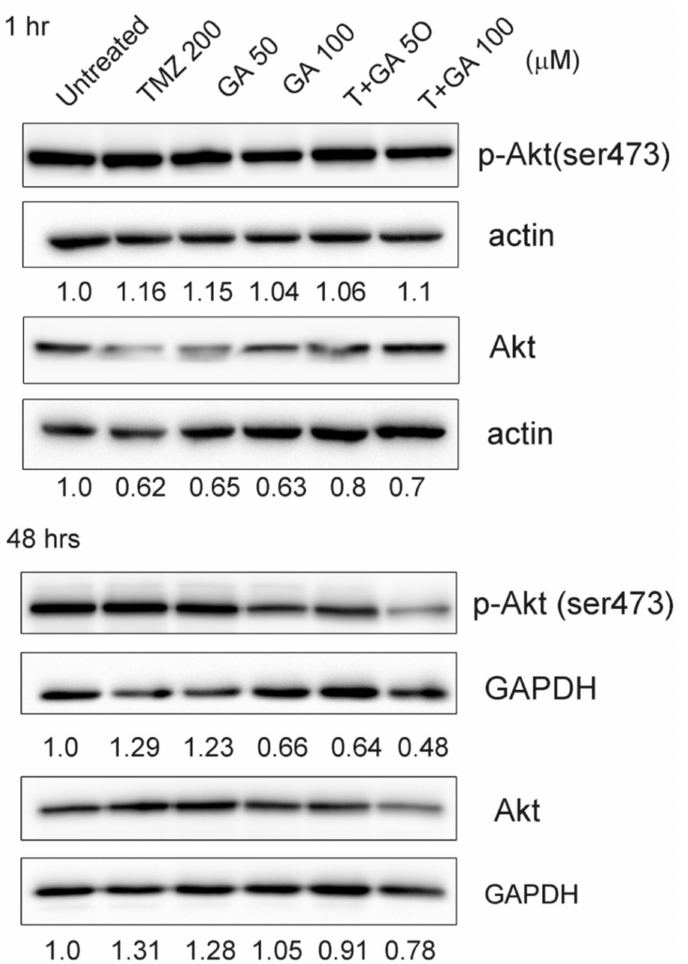
Figure 6. Expressions of p-Akt and Akt with TMZ, Ga or Ga/TMZ treatment. U87MG cells were cultured in 6 cm cultured dishes for 24 h, incubated with 200 µ M TMZ, 50 or 100 µ M Ga, or co- incubated with both for 1 and 48 h. After incubation, whole proteins were extracted. The expressions of Akt and p-Akt (Ser 473) were detected by Western blotting. These experiments were conducted at least 3 times; an illustrative experiment is shown. Numbers show the densitometric data of various incubated cellular groups normalized to their related untreated